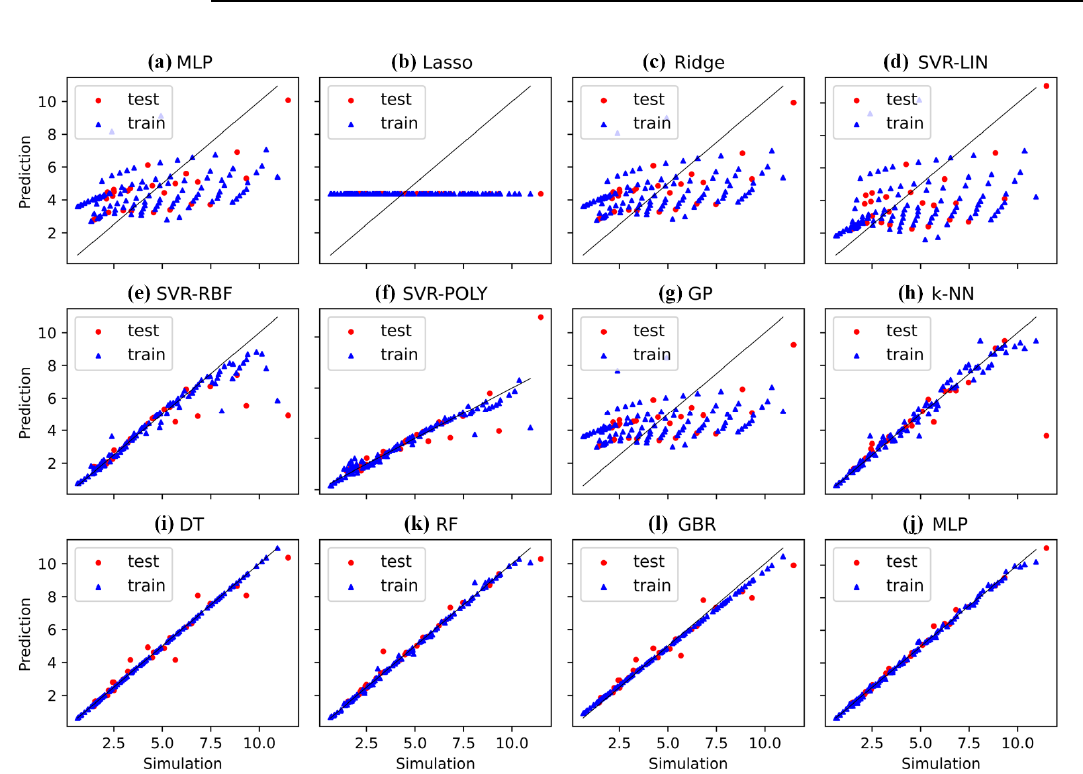
Figure 9. Simulation versus predicted values for thermal conductivity of the LJ fluid, being the output of 12 different algorithms ( a – l ). Data points include both training and test data. The 45 ◦ identity line denotes the perfect match.